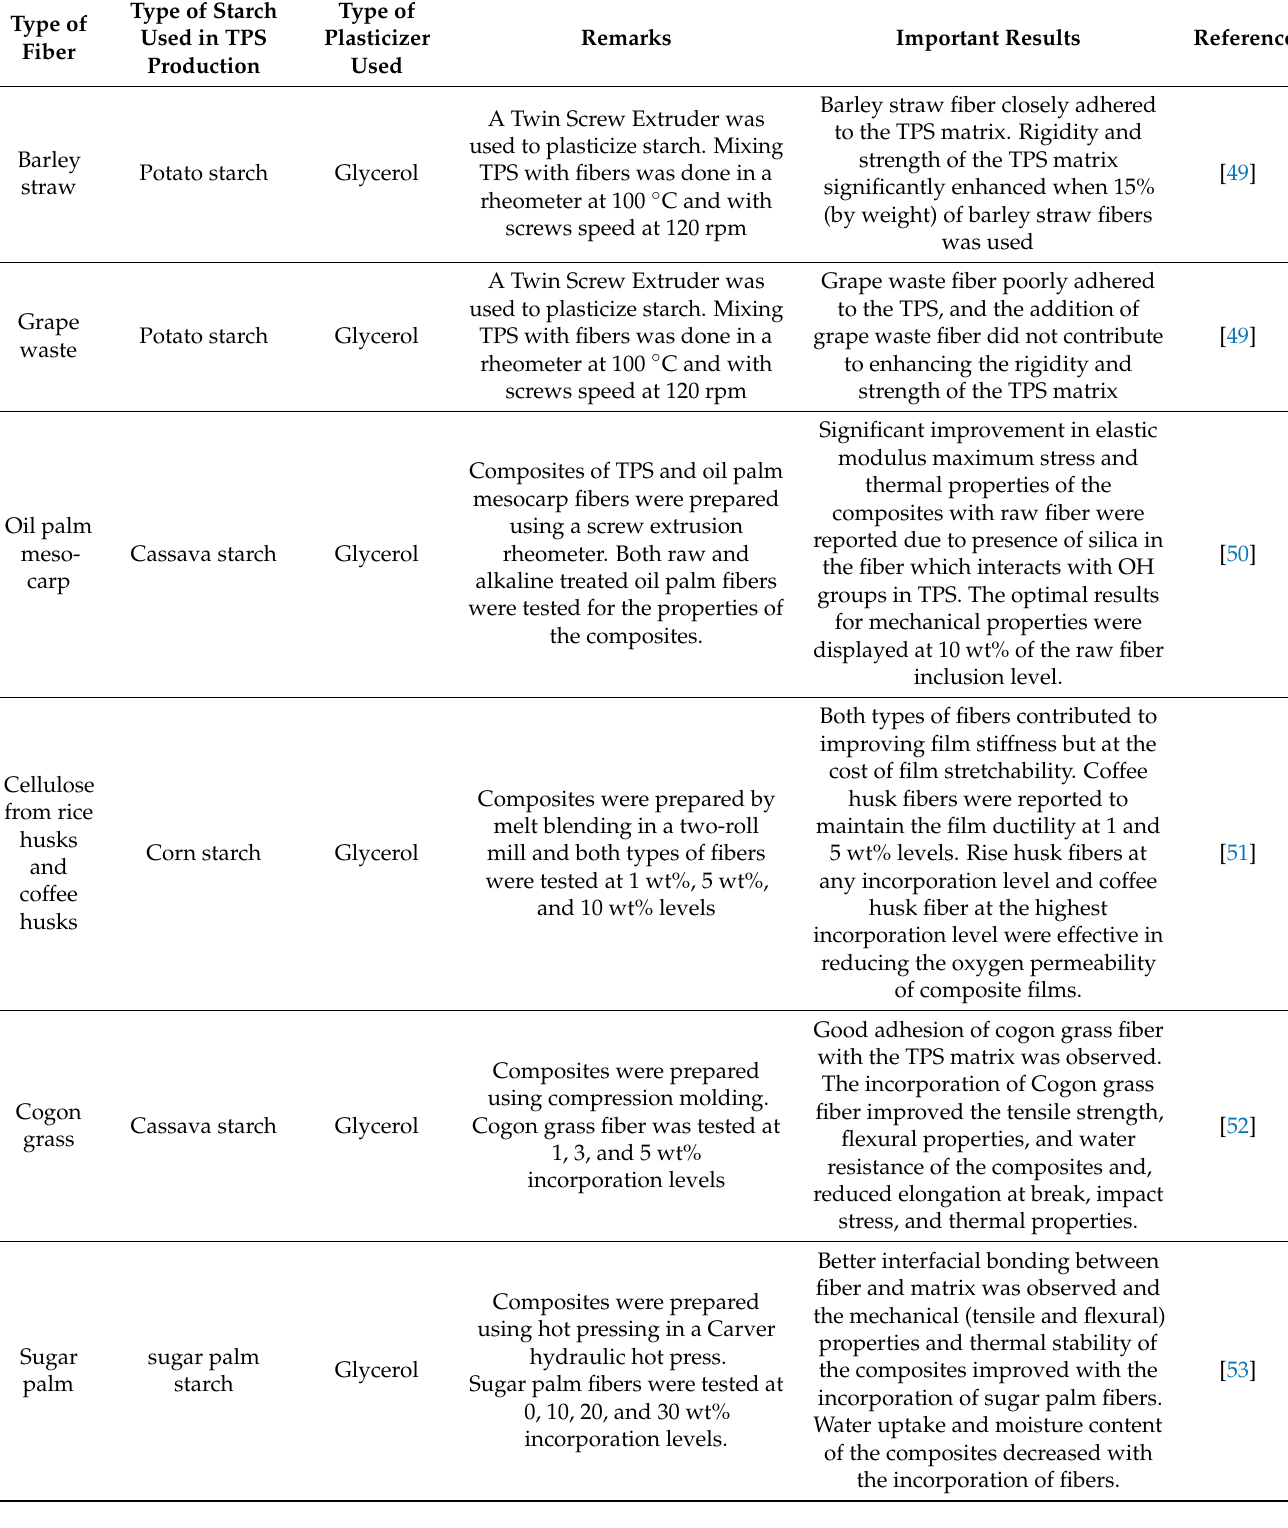
Table 1. Types of fibers used as reinforcing agents to produce thermoplastic starch